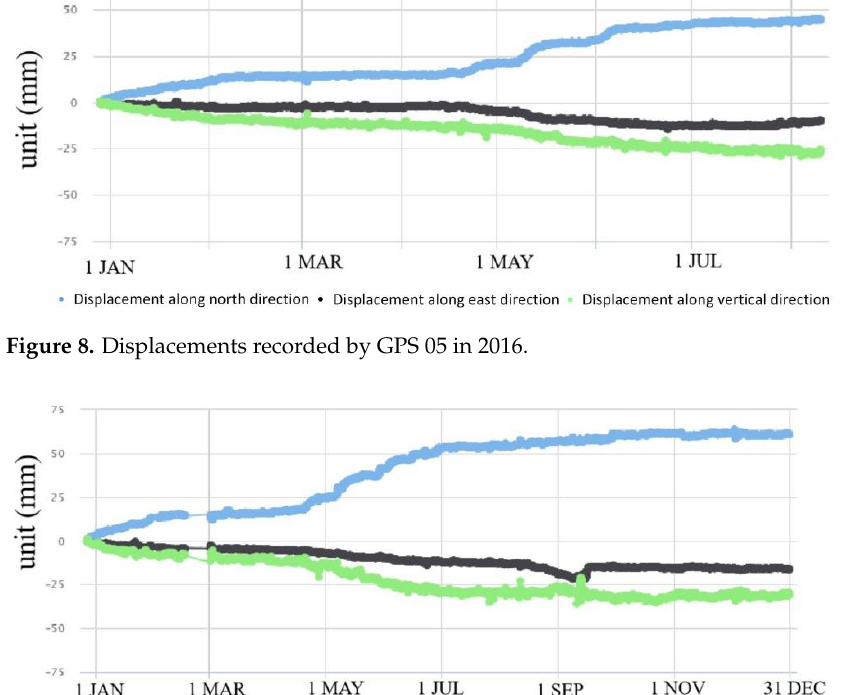
Figure 10. Displacements recorded by GPS 09 in 2016.